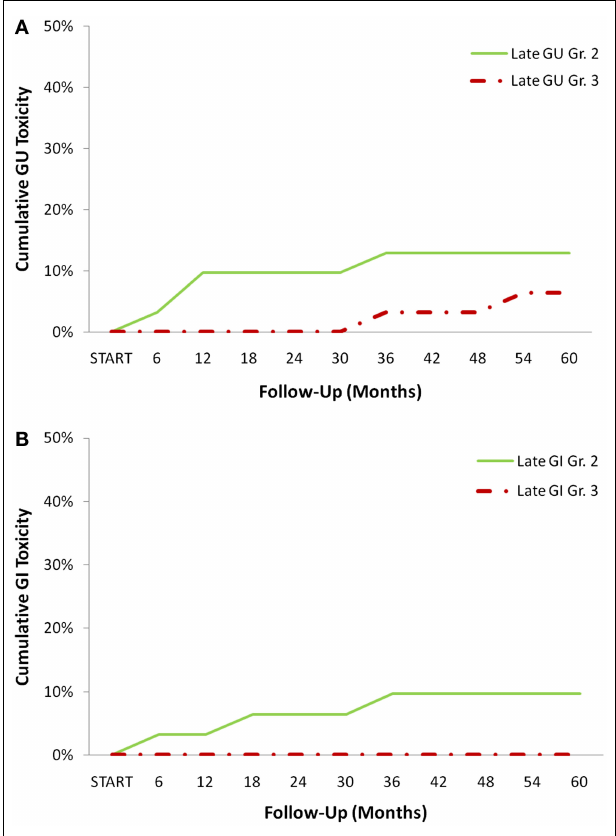
FIGURE 2 | Cumulative late CTCAE graded toxicities: (A) genitourinary (GU) and (B) Gastrointestinal (GI) toxicities at each time point .